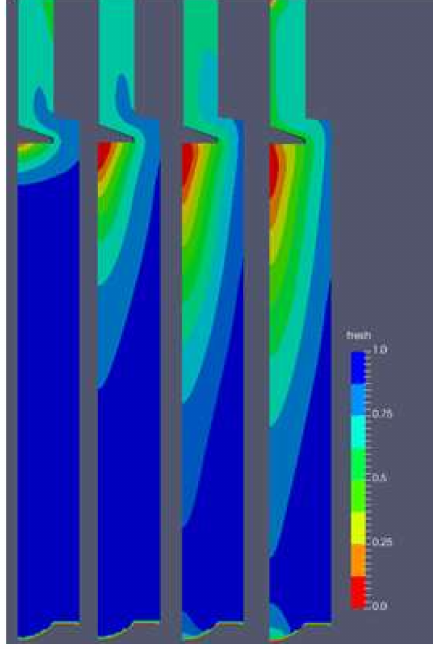
Figure 15. Fresh air propagation for the moment CA = 200 ◦ for the cases with scavenging port angles of 0 ◦ , 10 ◦ , 20 ◦ , and 30 ◦ respectively, from left to right. The depicted contours represent fresh air concentration (fresh air mass [kg]/total mass [kg]).